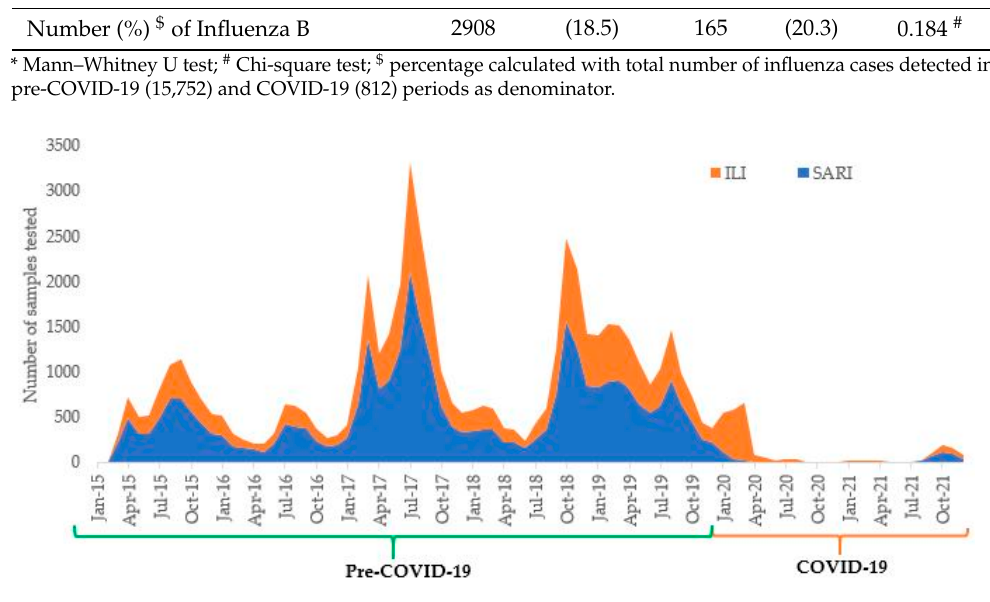
Figure 1. Clustered area diagram showing the number of samples tested (stratified by ILI and SARI) for influenza month-wise at MIV, Karnataka, India during 2015 to 2021. Abbreviations: MIV— Manipal Institute of Virology; ILI—influenza-like illness; SARI—severe acute respiratory illness. Of the samples tested, the majority were from females and came from the Karnataka state during the pre-COVID-19 and COVID-19 periods. About 20% of the samples during the pre-COVID-19 period were from pediatric patients (aged < 15 years) compared to 11% during the COVID-19 period. During the pre-COVID-19 period, the majority of the samples were from SARI patients (62%) in contrast to ILI patients (79%) during the COVID-19 period (Table